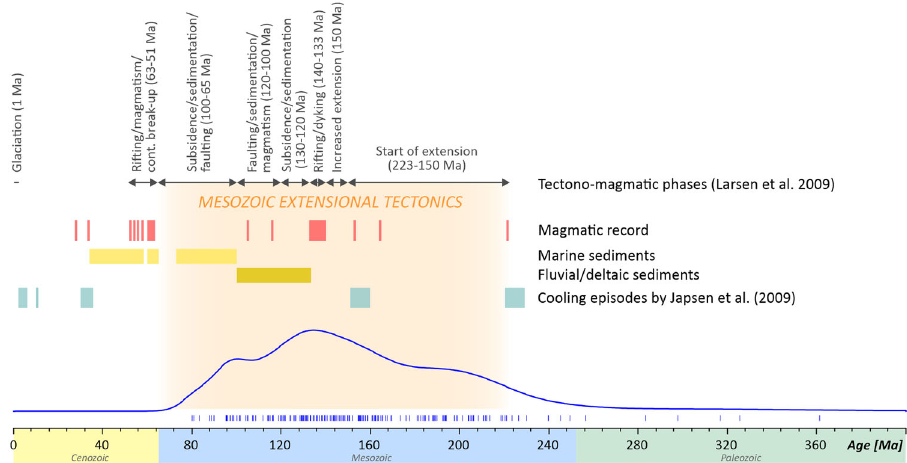
Fig. 4 Comparison of AHe dates with available geological data. Summary of the single grain AHe dates (blue tick marks) and their Kernel density estimate distribution (solid blue curve) compared to the tectono-magmatic phases 26 , geological record and cooling episodes identi fi ed in central West Greenland 11 .